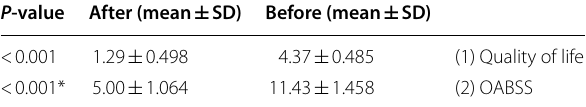
Asterisk represents significant difference between both groups: P value < 0.05 was considered statistically significant Table 4 Effect of tamsulosin plus solifenacin on group B P -value After (mean SD) Before (mean SD) ± ± < 0.001